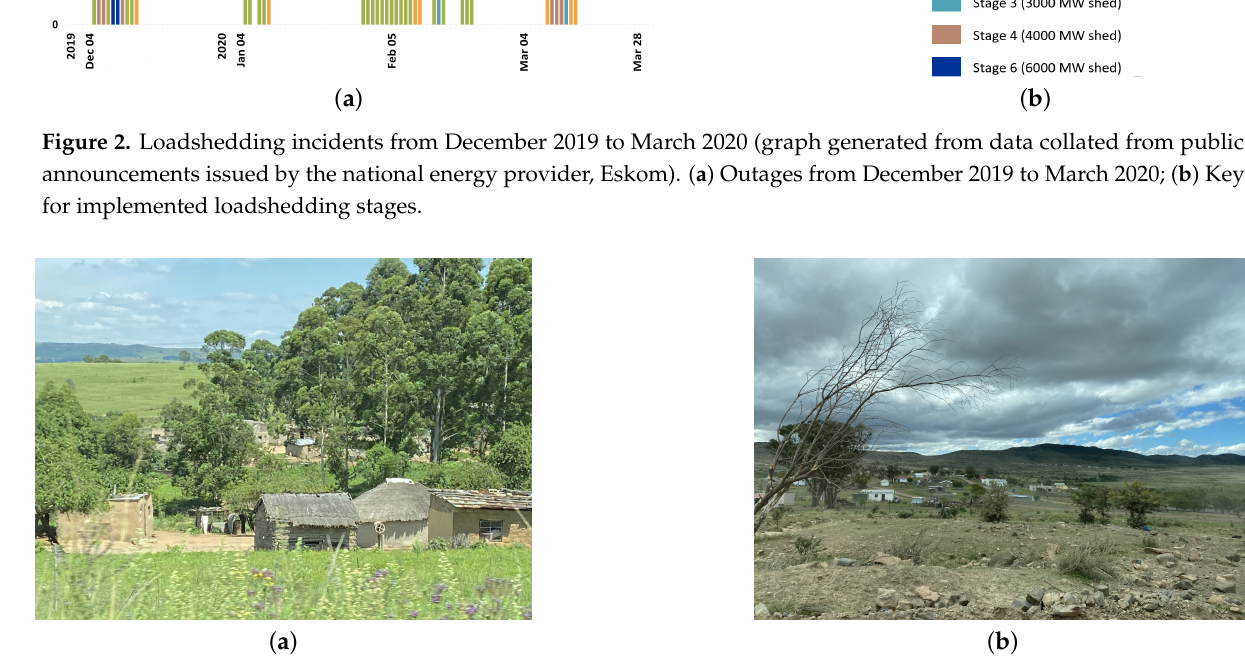
Figure 3. Rural S. African homesteads without electricity services. ( a ) Paulpietersburg, KwaZulu Natal, South Africa. ( b ) eNgojini, Eastern Cape, South